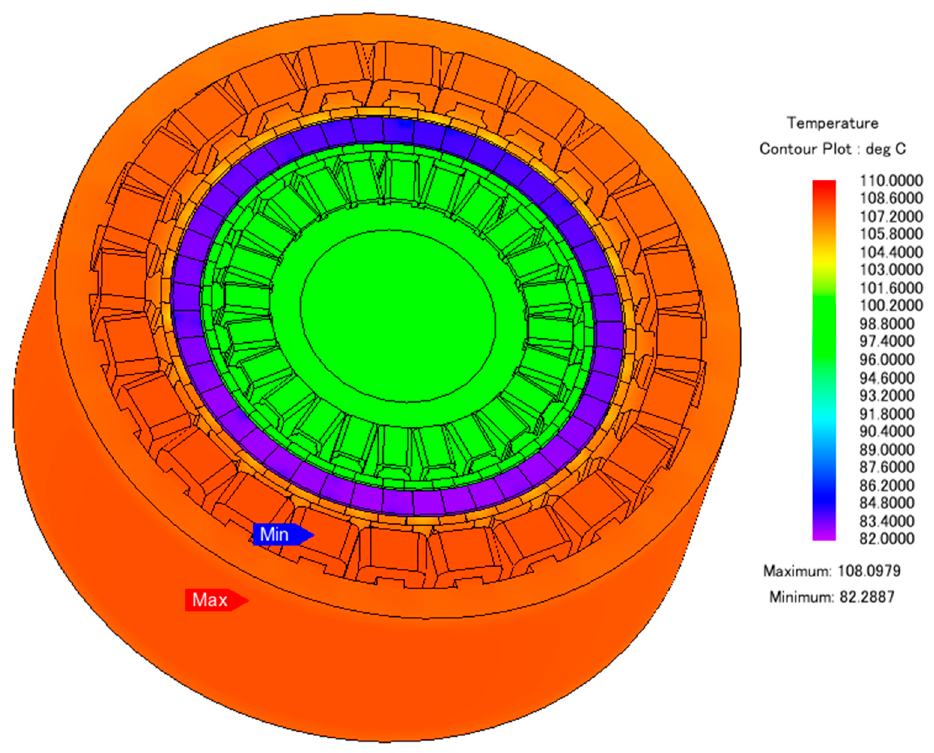
Figure 16. Temperature field distributions at 7200 s.